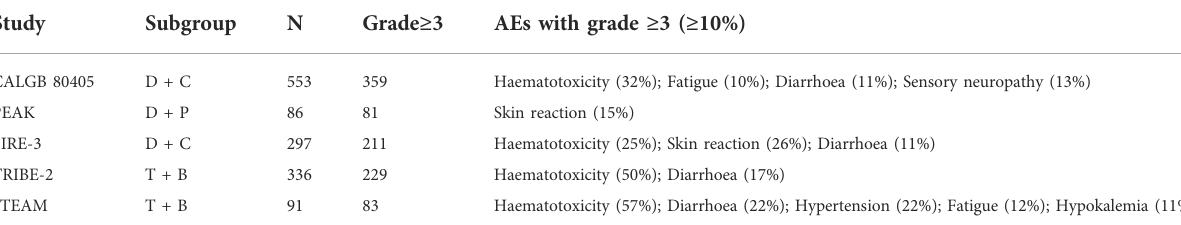
TABLE 2 The safety of different